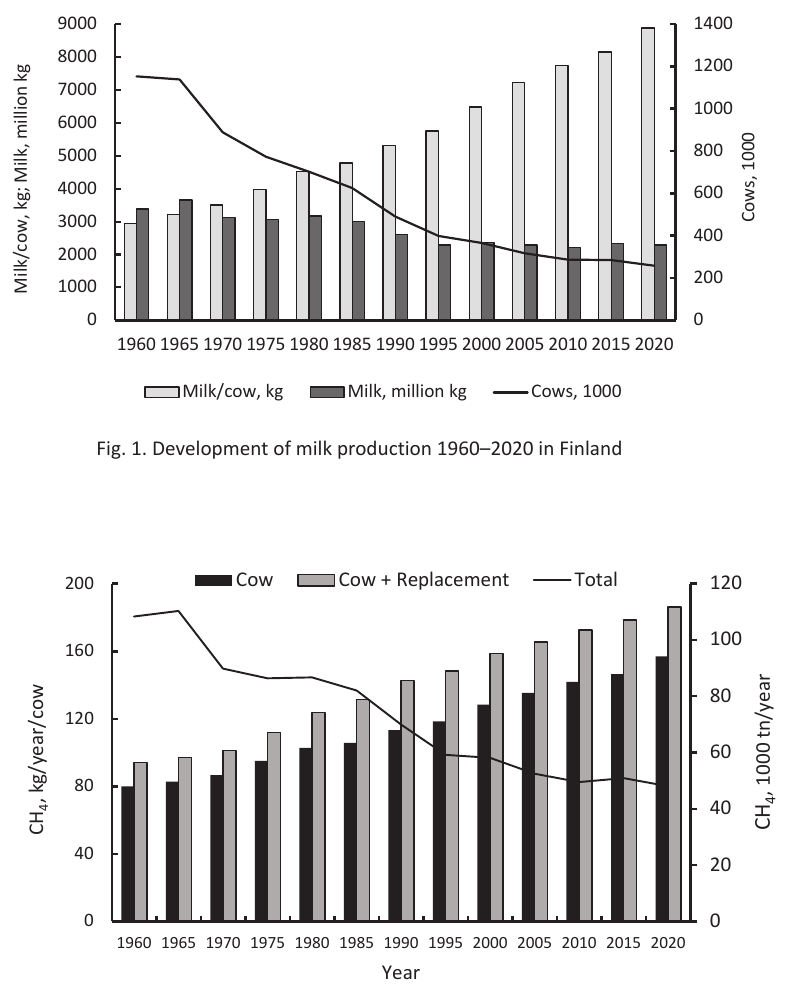
Fig. 2. Development of CH replacement (left axis) and total CH during 1960–2020 (right axis)